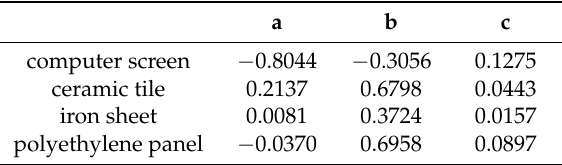
Figure 4. 3D visualization of the point cloud of the bright regions in Figure 3 by FugroViewer™ 3.0 (Fugro N.V., Leidschendam, the Netherlands), where (i), (ii), (iii), and (iv) are the points of the bright regions and (I), (II), (III), and (IV) are the points of the target planes. ( a ) Computer screen; ( b ) ceramic tile; ( c ) iron sheet; ( d ) polyethylene panel. The points of the centers of the bright regions in Figure 3 deviate significantly from the theoretical plane and can be approximately fitted by a cone (yellow curves). Table 1. Parameters of the theoretical plane derived by the points of the paper